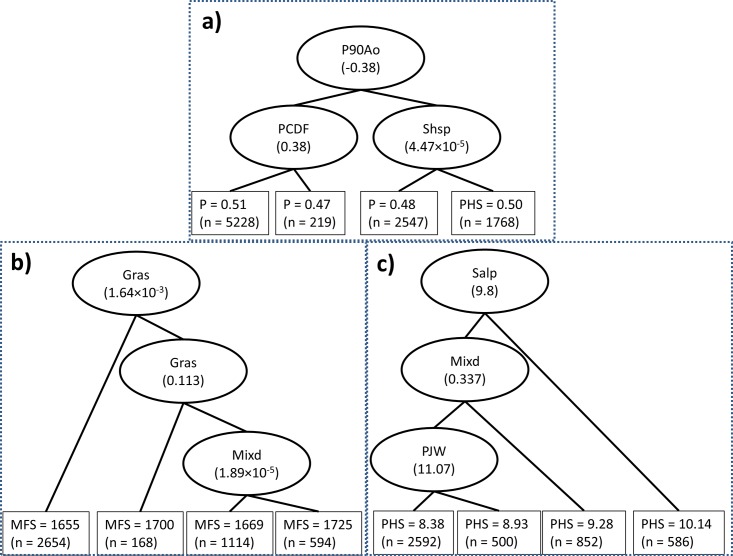
Simplified versions of the first tree of (a) fire occurrence model (b) fire size model, and (c) percent of high severity burning model computed with the boosted regression tree algorithm.The first three splits of each tree are shown to illustrate the interactions between key variables. The splitting variable and its corresponding splitting value are shown in oval above the node (variable abbreviation and units are provided in Table 1). The values in the rectangles at the terminal nodes represent the mean prediction and number of the records in the terminal nodes (n). The total number of records in the terminal nodes equals 0.75 (the bag fraction of the BRT model) of the total number of fires. Abbreviations: P: relative probability of fire occurrence; MFS: mean fire size; PHS: percent of high severity burning.